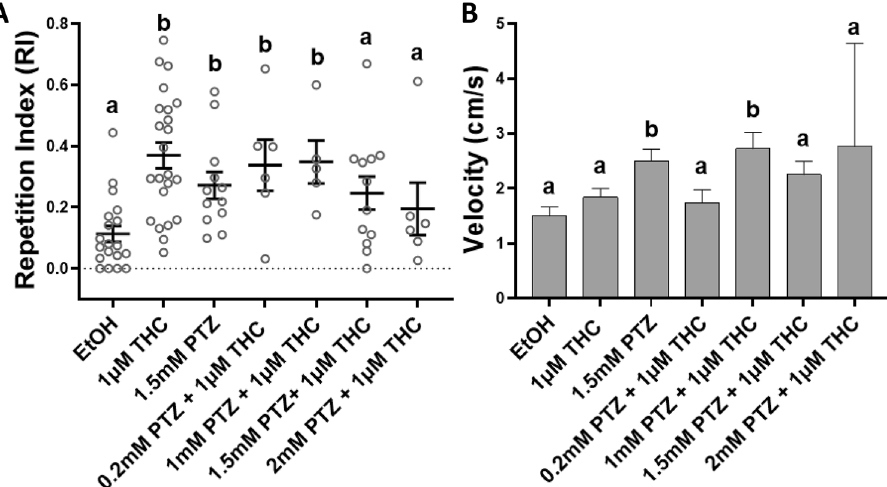
Figure 3. Co-administration of Tetrahydrocannabinol (THC) and GABA A receptor antagonist pentylenetetrazol (PTZ) affects the THC-induced behavioral stereotypy in adult zebrafish. ( A ) At 1.5 mM